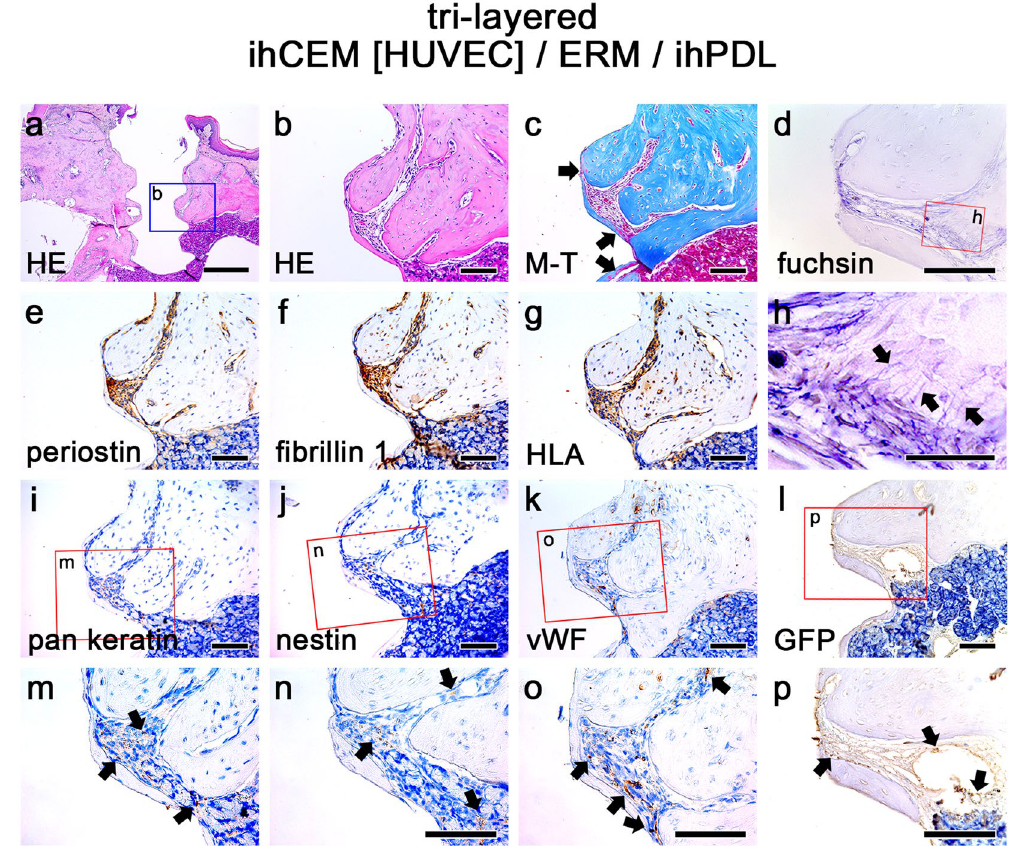
Figure 3. ERM cells play roles in PDL width regulation and calcification. ( a ) HE-stained image at 8 weeks after ihCEM [HUVEC]/ERM/ihPDL tri-layered cell sheet transplantation. ( b ) High magnification of panel a. Thin, calcified tissue formed on the surface of the fixture. The alveolar bone healed well in the direction of the fixture. The PDL-like tissue formed between the thin, calcified tissue and the alveolar bone. ( c ) M-T-stained image. The arrows indicate the red areas on the blue calcified tissue, indicating newly formed calcifying tissue. ( d , h ) Resorcin-fuchsin staining. Arrows indicate the oxytalan fibres in the PDL-like tissue. ( e , f ) IHC of periostin and fibrillin 1. In the PDL-like connective tissue, both PDL markers were strongly positive. ( g ) IHC of HLA. All PDL-like tissues and the areas of alveolar bone near the fixture showed positive signalling. ( i , m ) IHC of pan keratin (an ERM marker). Pan keratin positive cells were observed in the PDL-like tissue (arrows). ( j , n ) IHC of nestin (a nerve marker). Nestin positive cells were observed in the PDL-like tissue (arrows). ( k , o ) IHC of vWF. Small blood vessels were formed in the PDL-like tissue and alveolar bone (arrows). ( l , p ) IHC of GFP. Arrows shows blood vessels in the PDL-like tissue originated from GFP tagged HUVECs. Scale bars, ( a ) 500 μ m; ( b – g , i – p ) 100 μ m; ( h ) 50 μ